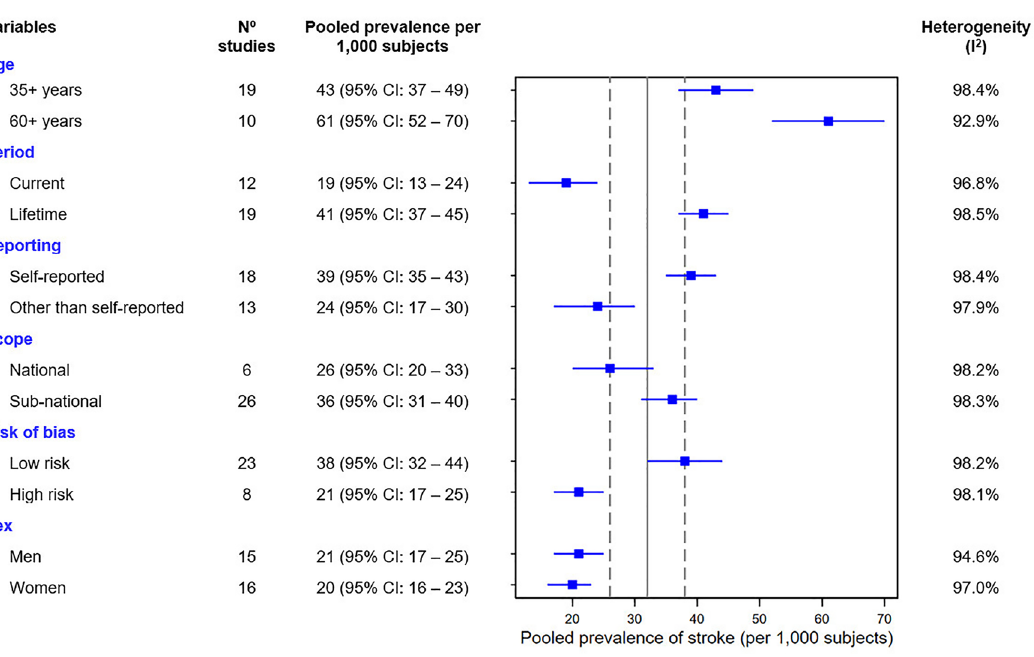
Figure 4. Forest plot of prevalence rate about stroke in subgroup analysis according to different variables of interest. Meta-analysis was calculated by fitting a logistic-normal random-effect model without covariates and heterogeneity was assessed with the statistical test I 2 . Vertical continuous line represents the overall estimate of the prevalence of stroke in the general population and dashed lines represent the 95% confidence interval (CI). Detailed forest plot of the general population prevalence rate in Supplementary Figure